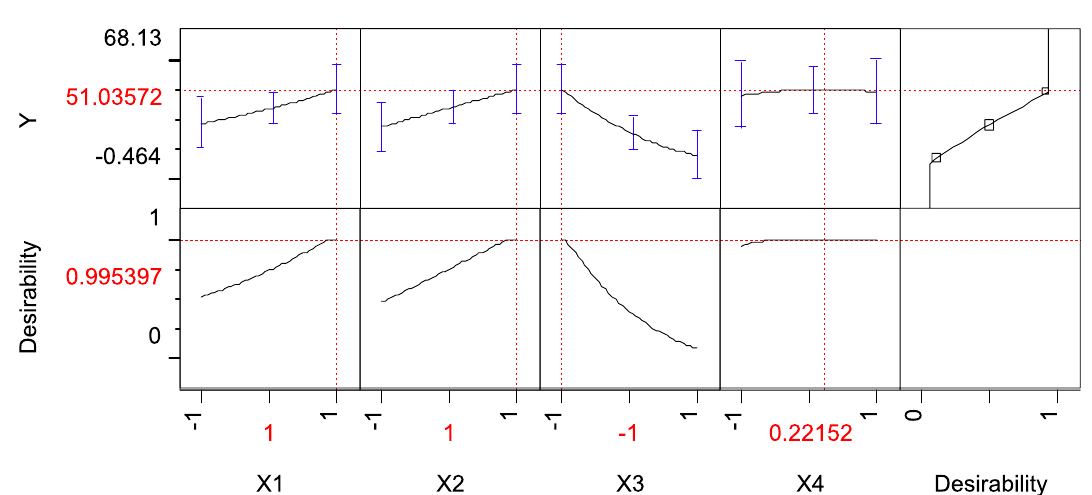
Figure 4. JMP Desirability prediction profile showing the predicted optimal levels of studied four variables, X1 (pH), X2 (Glycerol), X3 (agitation) and X4 (NaCl); along with the predicted biosurfactant as (1/ST) × 1000 produced by Natrialba sp.